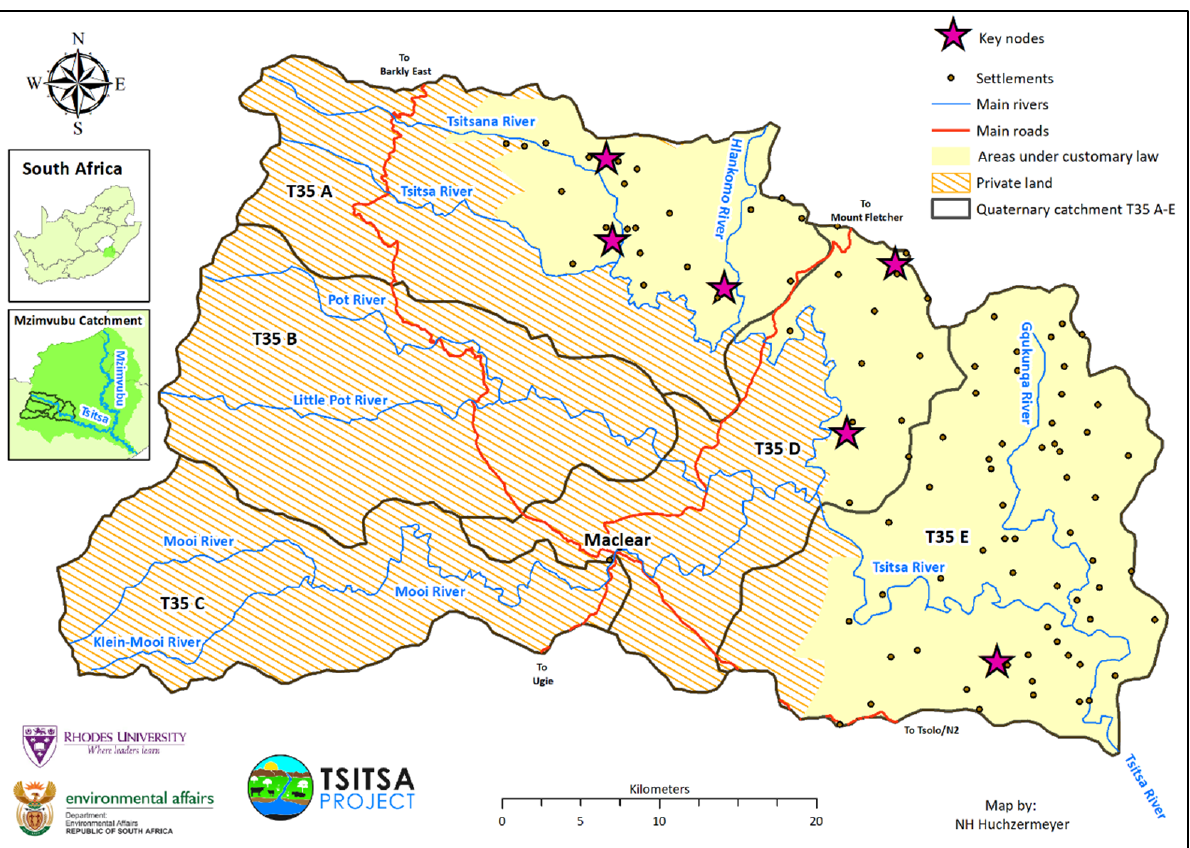
Figure 1. Map of the Tsitsa River Catchment. Quaternary catchments are hydrological delineations of sub-catchments (numbered by the South African system of T35 A–E); and key nodes refer to focal areas for the Tsitsa Project’s engaged research and restoration work. Map by N.H. Huchzermeyer.